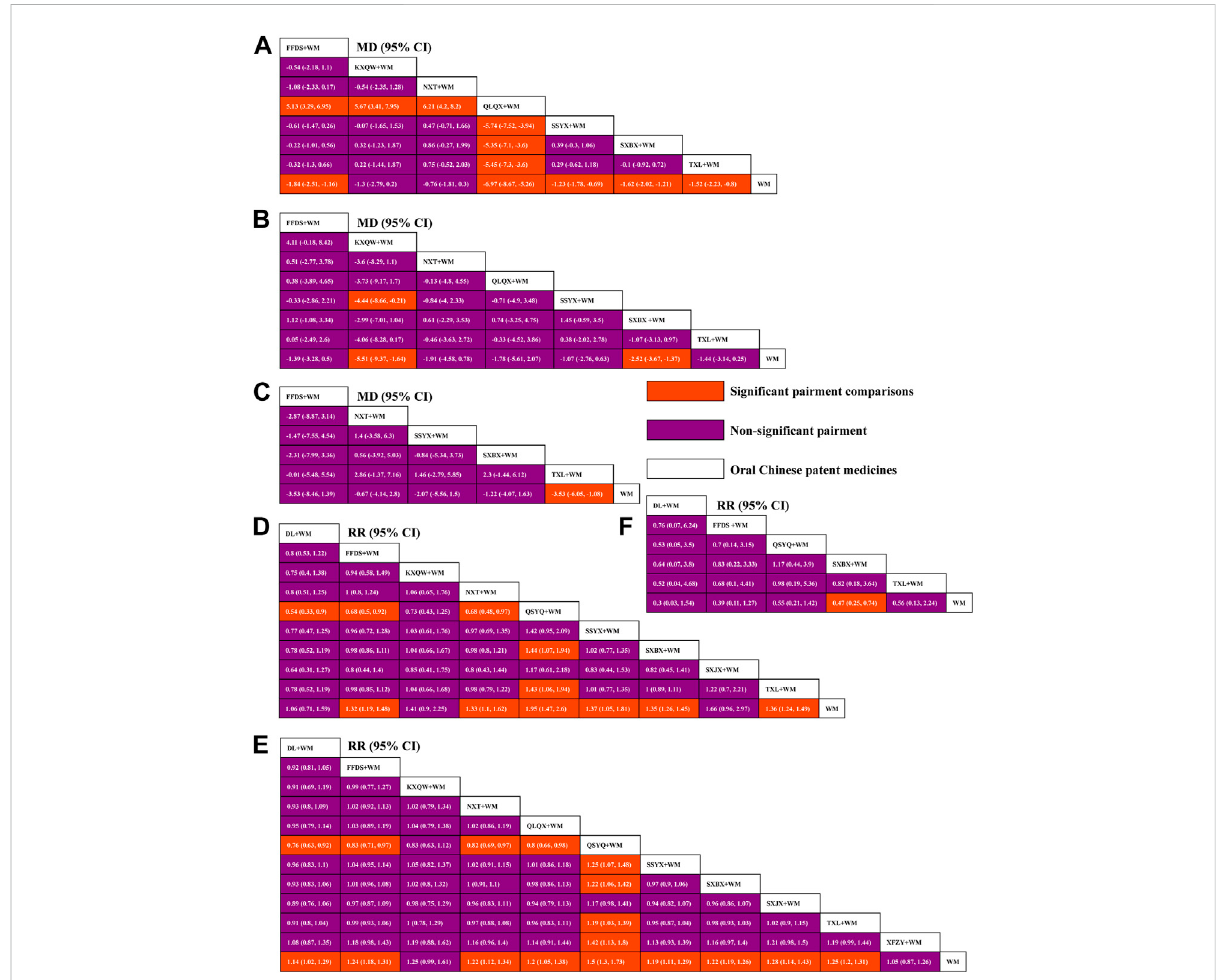
FIGURE 3 League tables for comparison between each intervention. (A) Weekly frequency of angina; (B) Duration of an angina attack; (C) Weekly nitroglycerinusage; (D) EffectiverateinECG; (E) Clinicaleffectiverate; (F) Cardiovasculareventsrate;WM,Westernmedicine;FFDS,FufangDanshen dripping pill; DL, Danlou tablet; KXQW, Kuanxiong aerosol; NXT, Naoxintong capsule; QLQX, Qiliqiangxin capsule; QSYQ, Qishen Yiqi dripping pill; SSYX, Shensong Yangxin capsule; SXBX, Shexiang Baoxin pill; SXJX, Suxiao Jiuxin pill; TXL, Tongxinluo capsule; XFZY, Xuefu Zhuyu